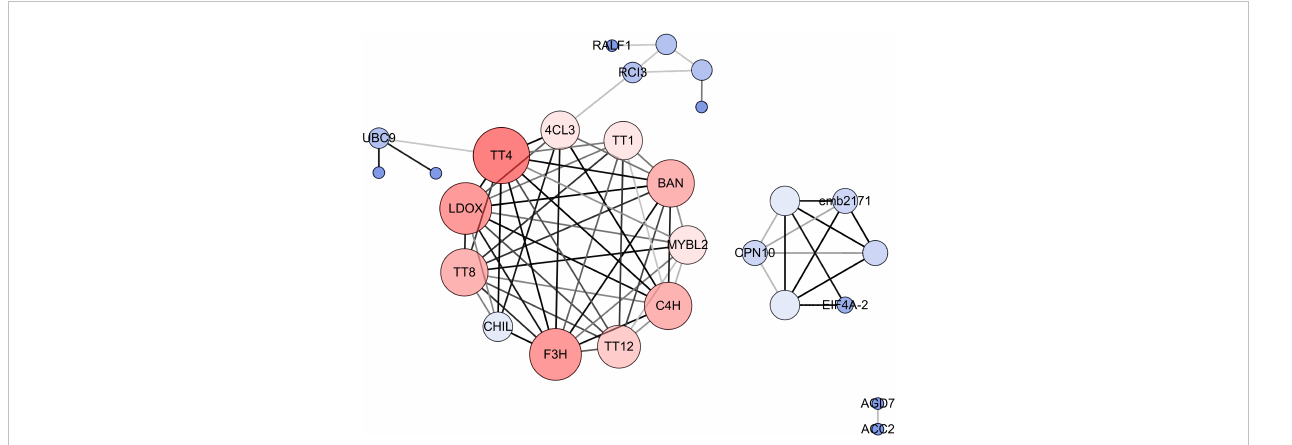
FIGURE 5 PPI networks for hub genes involved in B. napus seed color. The size and color depth of the circle represent the degree of center, and the color depth of the line represents the degree of correlation. Crucial genes were identi fi ed based on eigenvector centrality (EGC), degree centrality (DC), and closeness centrality (CC), which were calculated using the Cytoscape_v3.7.2 plug-in